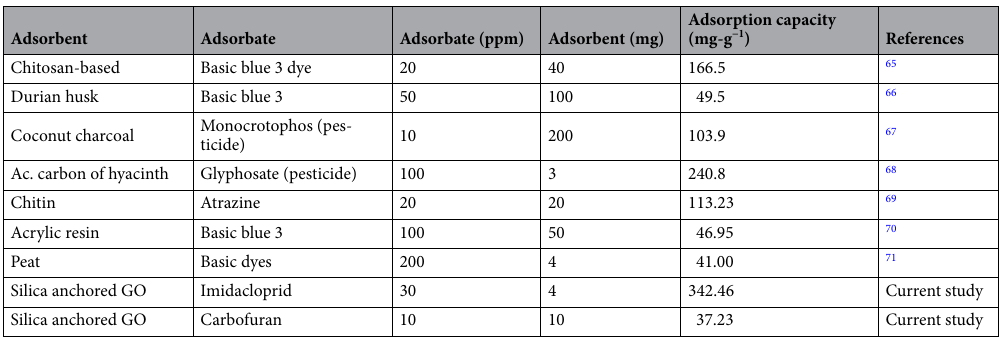
Table 7. Comparison of adsorption capacity of the composite of current study with those of the adsorbents reported in literature.